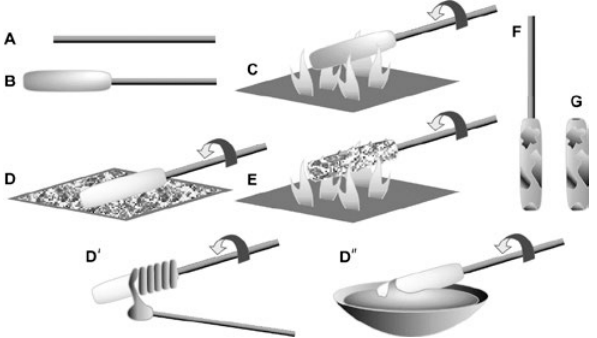
Figure 3. Production of core-molded vessels: (A) metal or wood- en rod; (B) formation of core form; (C) firing the core; (D) glass application via rolling in crushed glass; (E) firing of applied layer; (F) completed object; (G) vessel after removal of rod/core. Alternate methods for glass application: (D’) coiling strands of softened glass around the mold or (D”) dipping the core in molten glass [adapted from reference 42 with permission from Springer Nature].